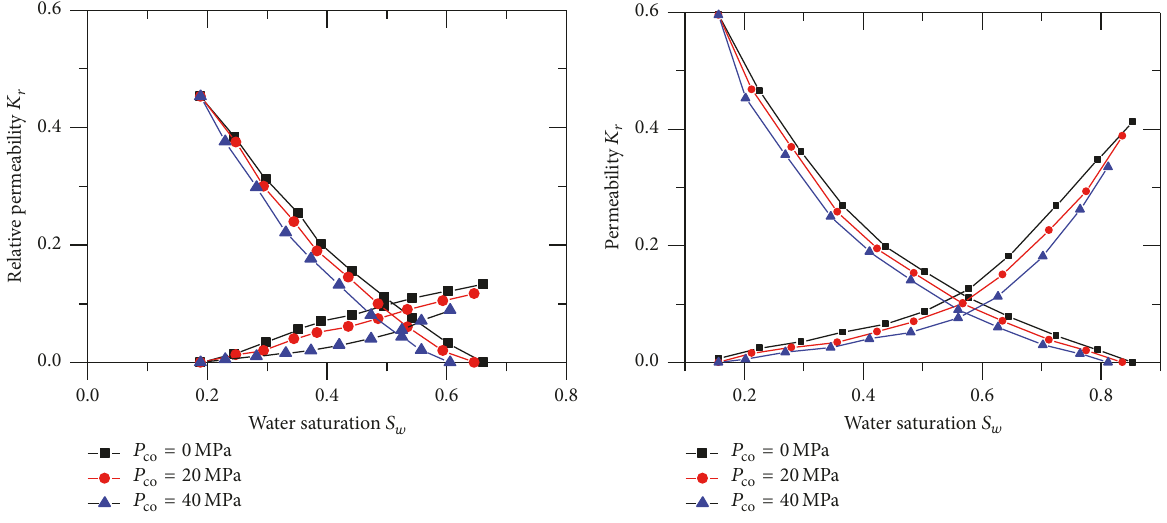
Figure 10: Effects of stress on the relative